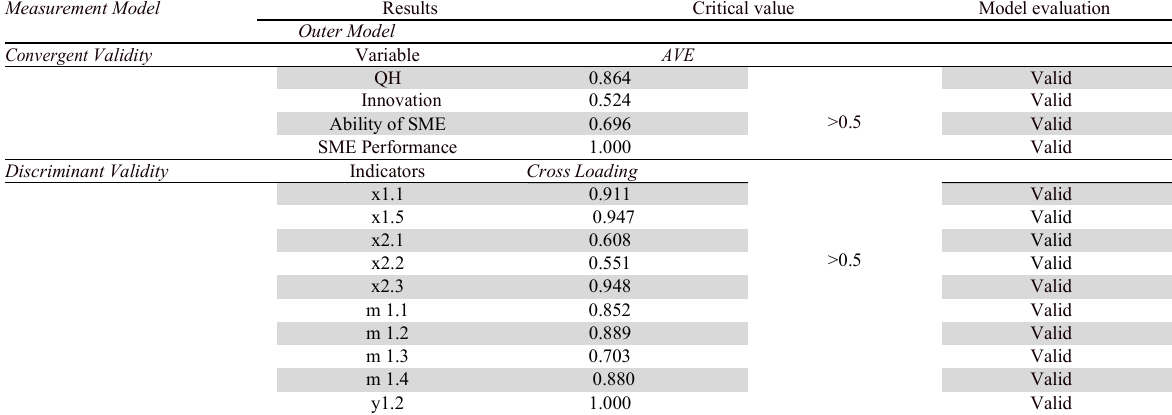
Measurement fit model Spain craft sub sector Measurement Model